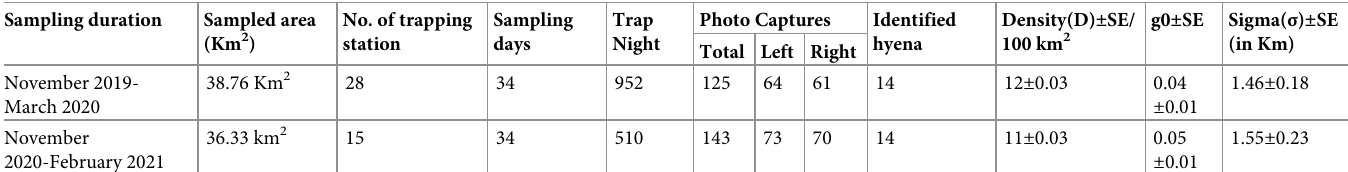
Table 1. Summary of camera trapping effort at the study site of Sawai Mansingh Wildlife Sanctuary, Rajasthan during 2019–2020 and 2020–2021. Sampling duration Sampled area (Km 2